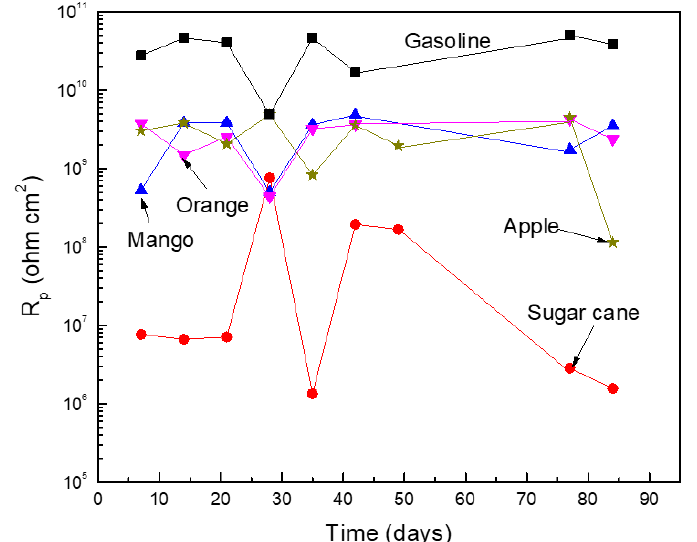
ff erent ethanol–gasoline